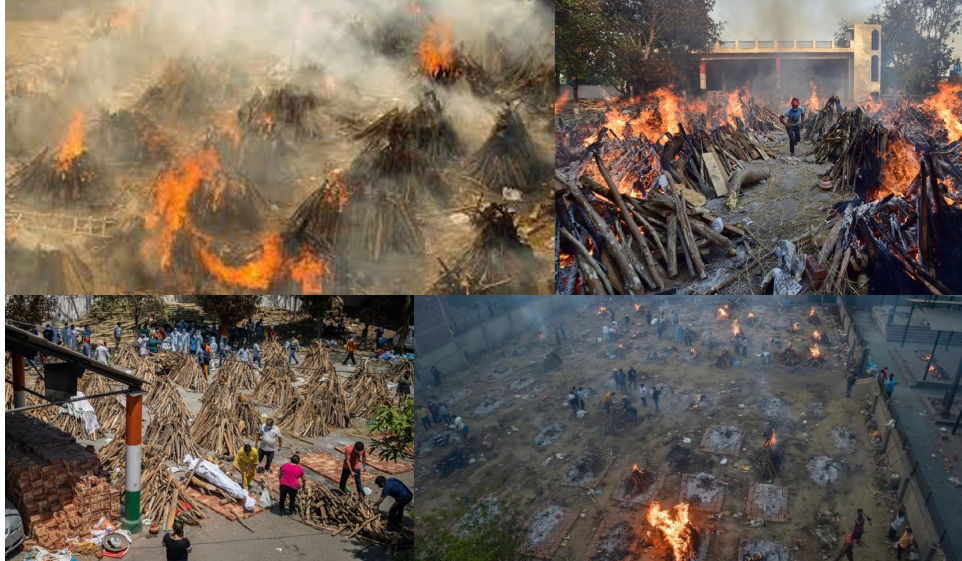
Figure 1. Massive open-air pyre for cremation of COVID-19 victims at various crematoriums in New Delhi during March through May in 2021, reported in the media. (Images courtesy of ( top left ) https://www.newindianexpress.com, accessed on 12 May 2022 ( top right ) www.oneindia.com, accessed on 12 May 2022 ( bottom left ) https://www.outlookindia.com, accessed on 12 May 2022 ( bottom right ) https://in.news.yahoo.com, accessed on 12 May